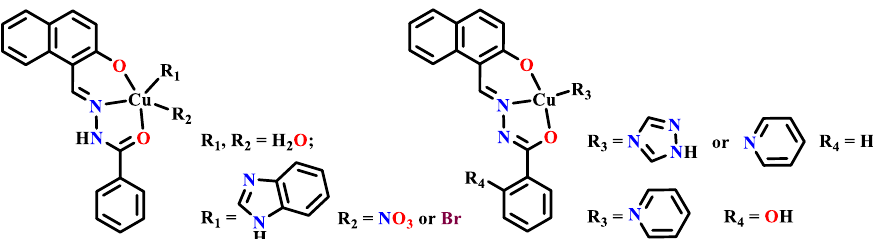
Figure 21. A series of Cu(II) complexes of naphthylhydrazone with benzamide derivatives as side chains together with different co-ligands for SAR studies, recently reported by F. Yang’s